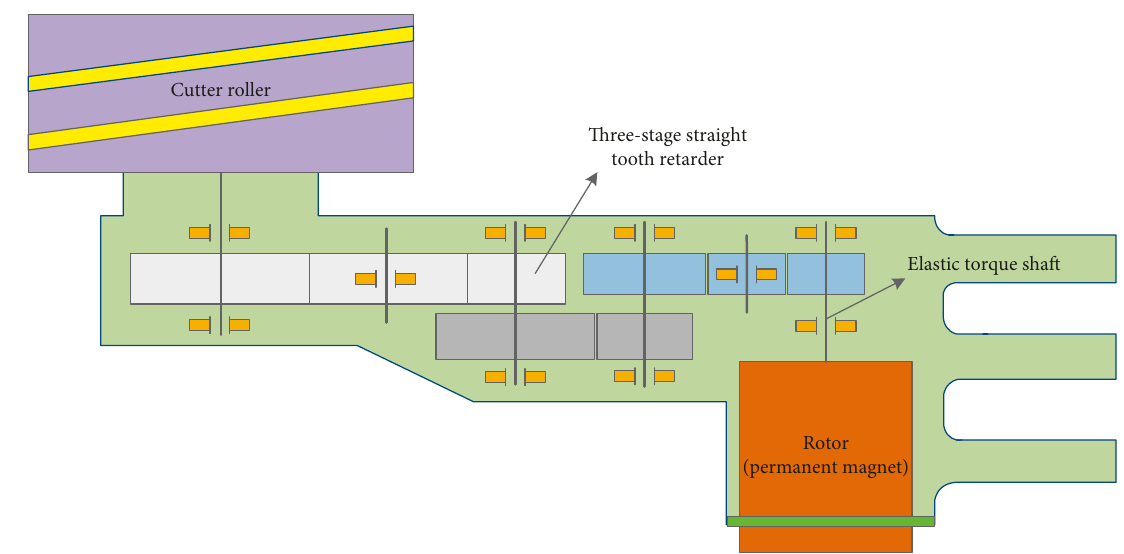
Figure 1: Schematic diagram semidirect cutting transmission